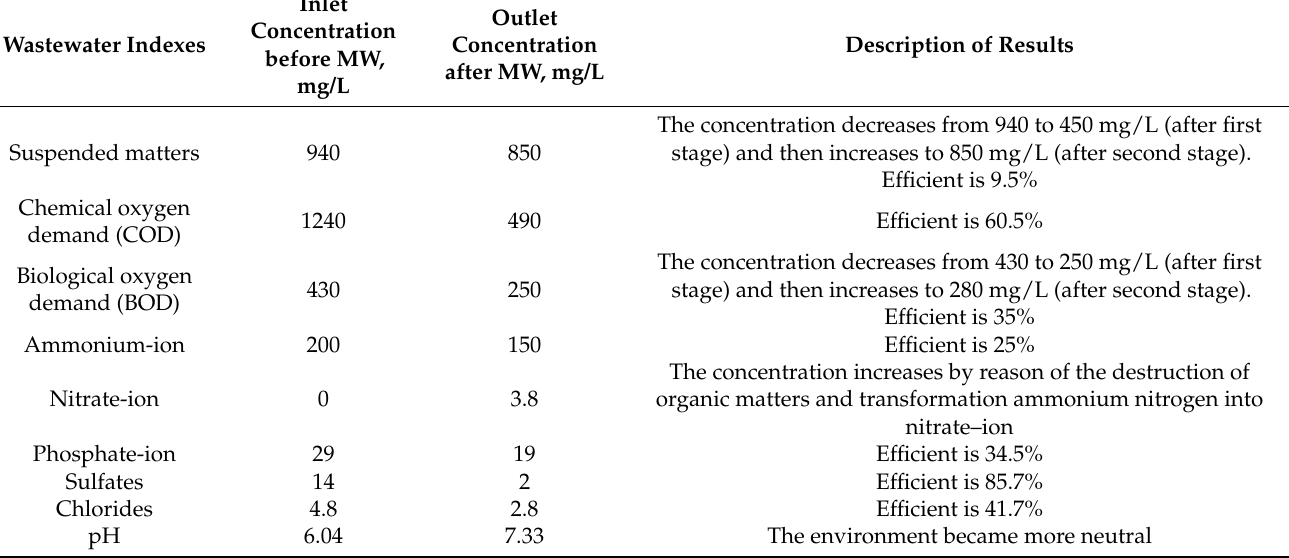
Table 4. Water indexes change after MW treatment